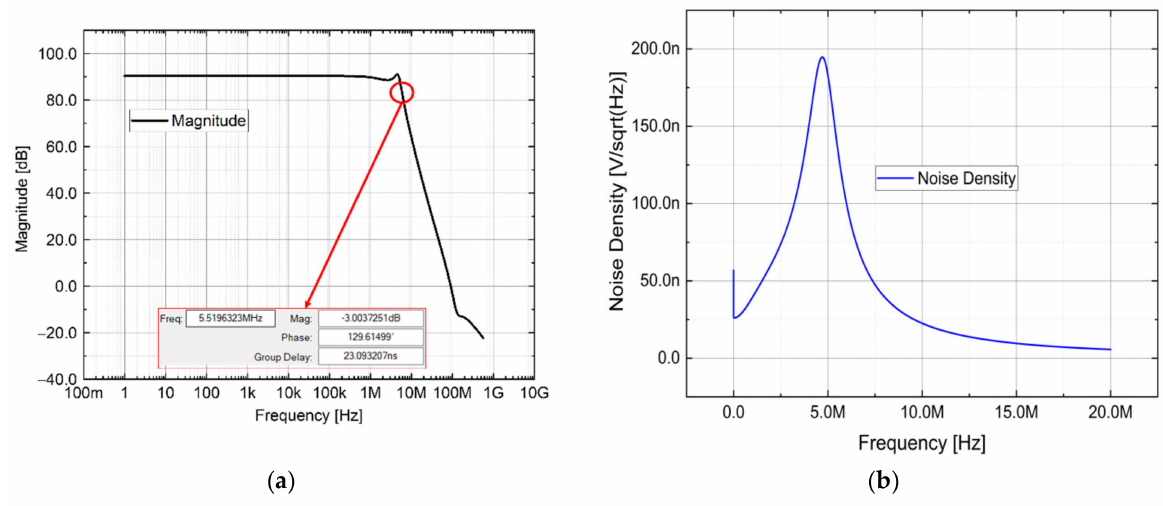
Figure 5. ( a ) Bode diagram and ( b ) noise density simulations of the optoelectronic